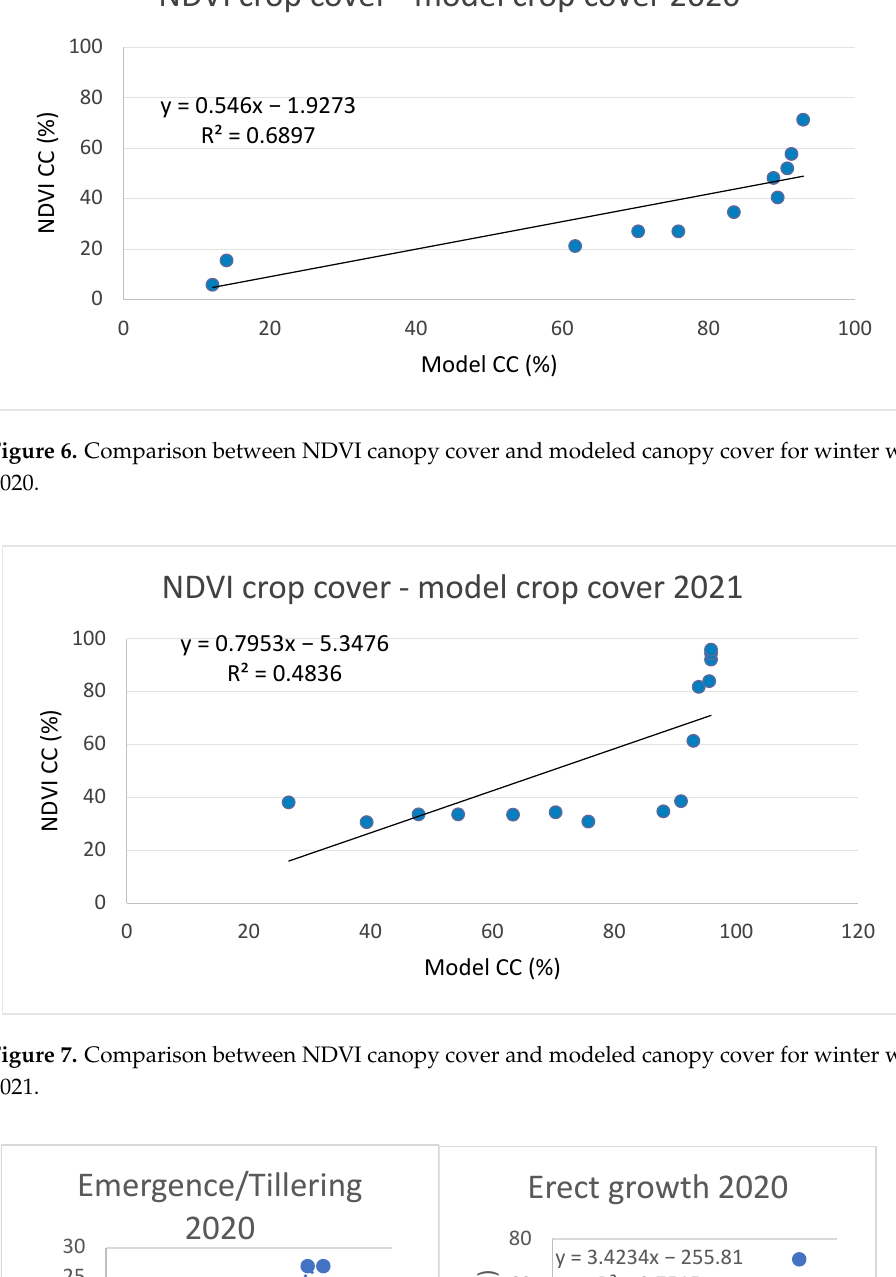
y = 0.2633x + 6.8853